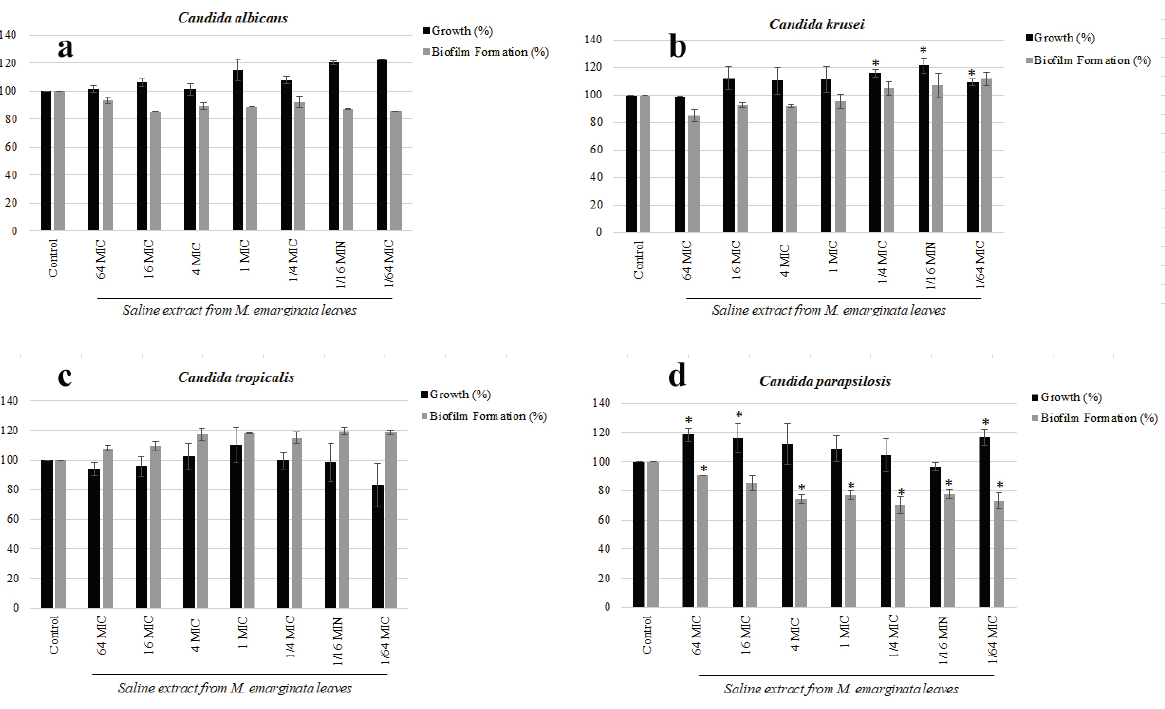
Figure 2 - Analysis of the antibiofilm activity of Malpighia emarginata saline extract to species of Candida albicans (a), Candida krusei (b), Candida tropicalis (c) and Candida parapsilosis (d). Assays performed in triplicate. p <